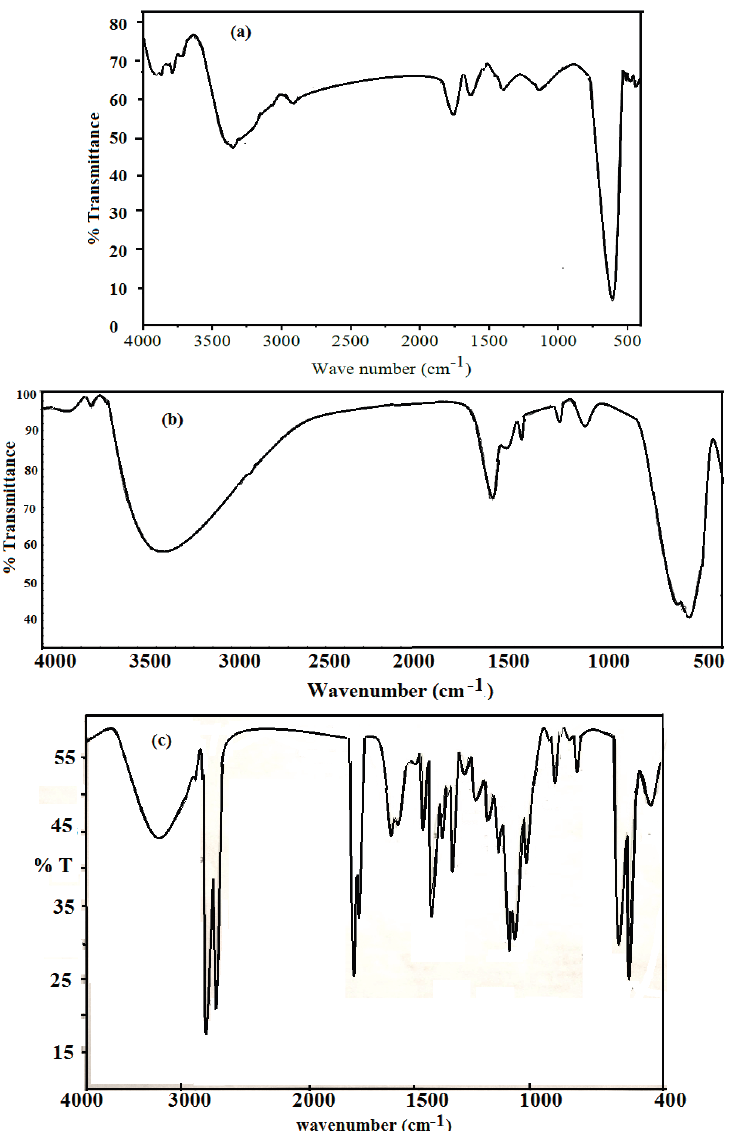
Figure 1. FTIR spectra of ( a ) hydrophilic magnetite coated with PVP; ( b ) hydrophobic magnetite coated with oleic acid and ( c ) AA-Na/magnetite